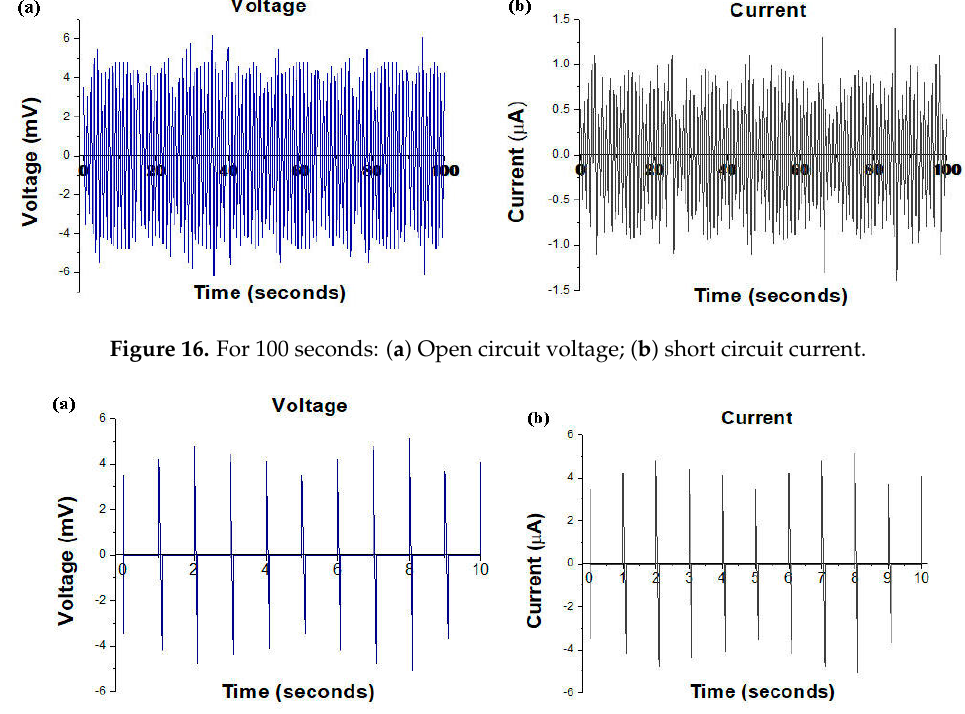
Figure 17. For 10 seconds: ( a ) Open circuit voltage; ( b ) short circuit current.